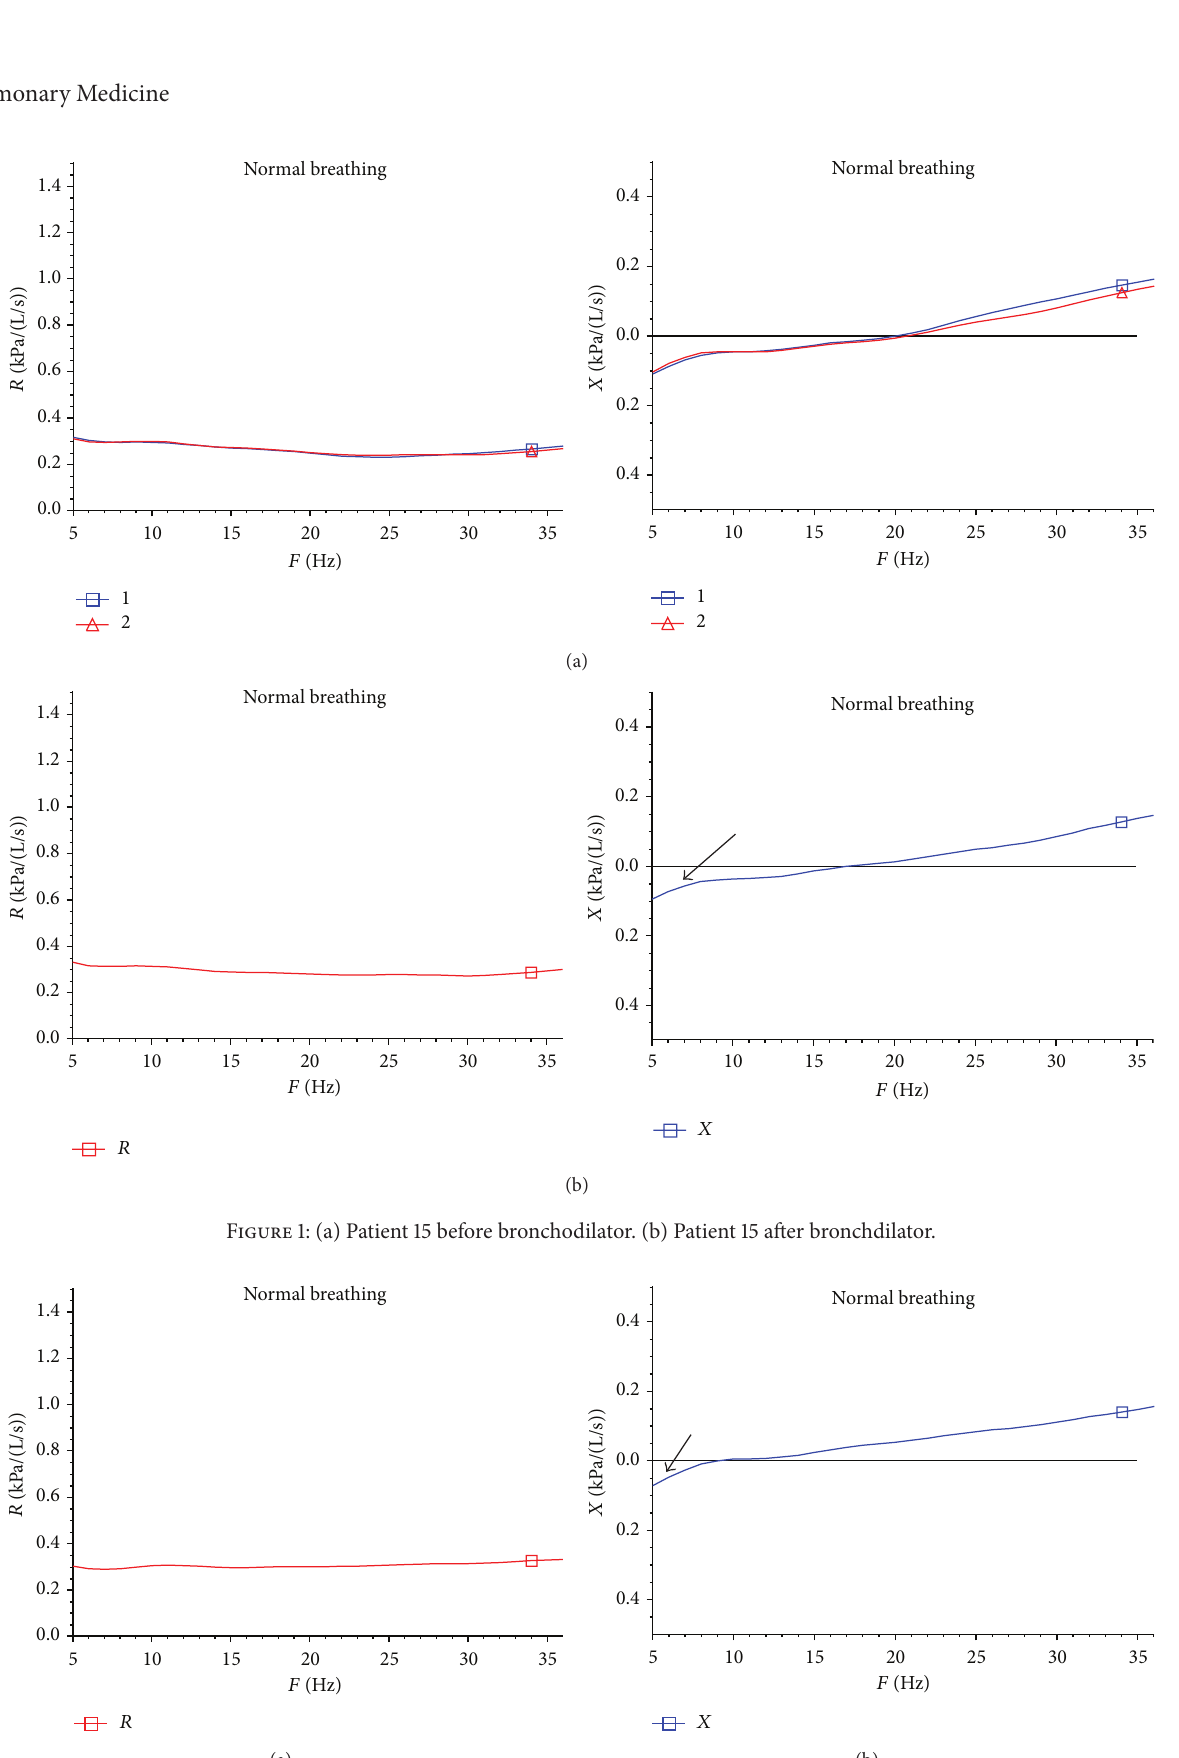
Figure 2: Patient 15 followup (post) (shadowed area